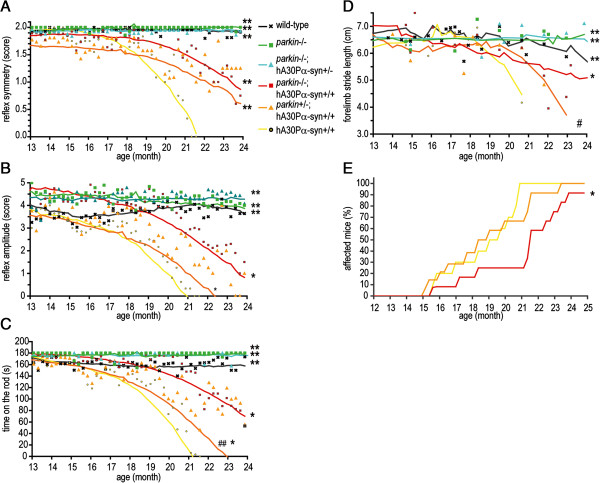
Parkin deficiency delays the appearance of motor dysfunction in hA30Pα-syn mice in a dose-dependent manner. Motor functions were assessed with the extension reflex (A, B), the rotarod (C) and footprint (D) tests. For each test and for each genotype, the mean performance scores are presented as a function of age (n = 11–14 per genotype); the curves correspond to the weight-adjusted models used for the statistical comparisons. (E) The penetrance of the phenotype was calculated as the age at which the animals were unable to perform the rotarod test (Kaplan-Meier analysis). *; **: different from hA30Pα-syn+/+ mice with p < 0.01; p < 0.0001; #; ##: different from parkin-/-; hA30Pα-syn+/+ mice, with p < 0.05; p < 0.0001.